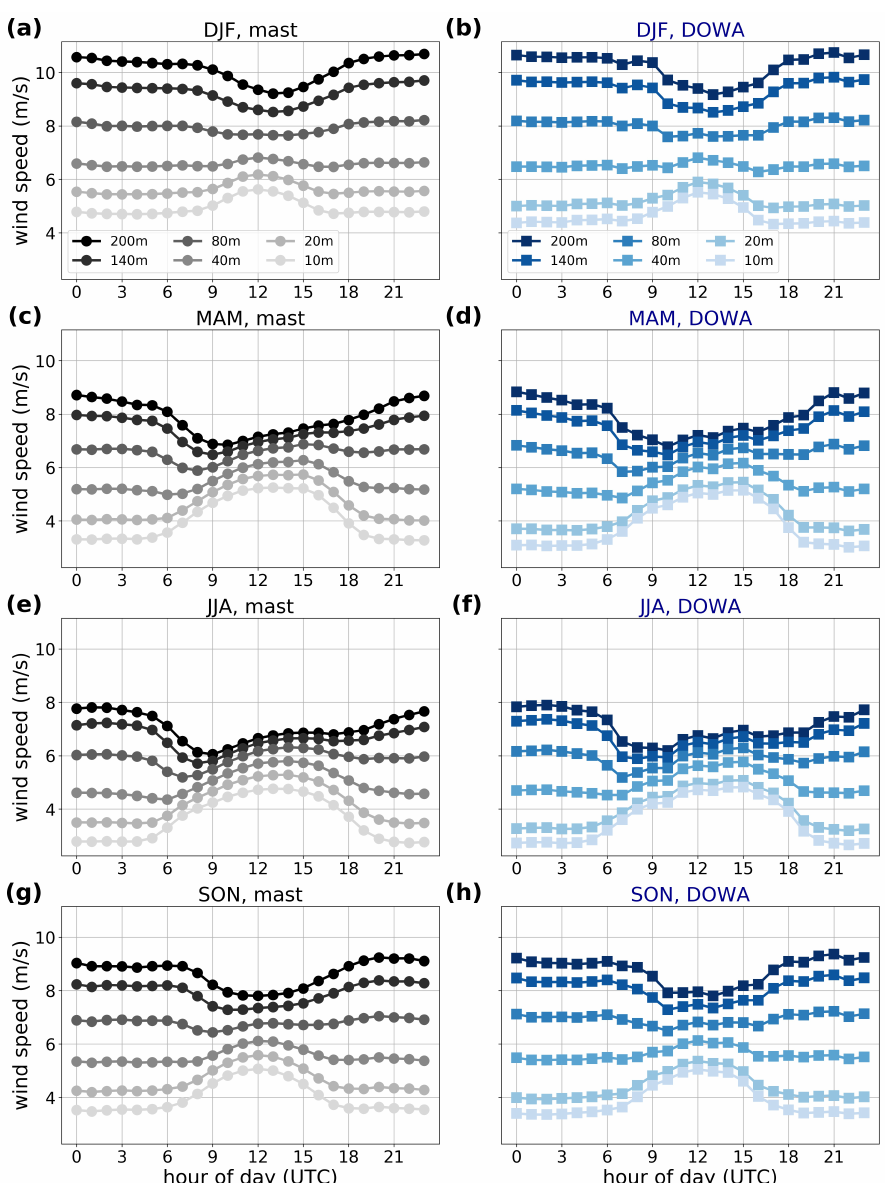
Figure 7. Hourly mean wind speed for the mast measurements ( a , c , e , g ) and DOWA ( b , d , f , h ), separated into the four seasons: ( a , b ) winter (December, January, February), ( c , d ) spring (March, April, May), ( e , f ) summer (June, July, August), and ( g , h ) autumn (September, October,